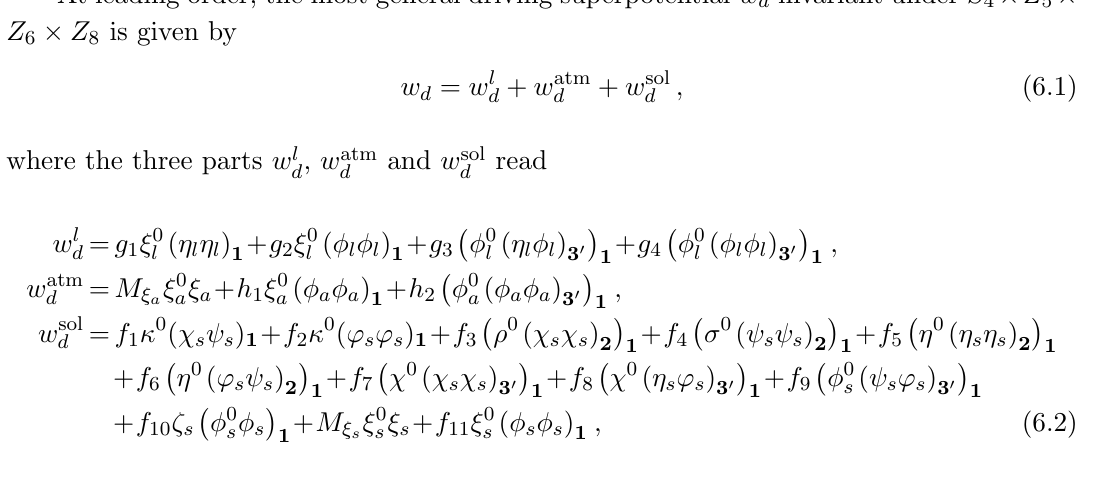
(cid:30) , (cid:24) and (cid:24) are required in order to achieve the desired vacuum con(cid:12)guration. s a s